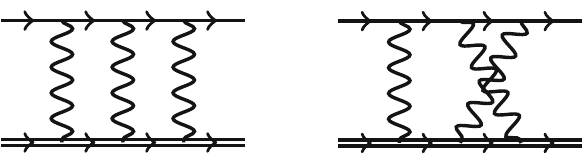
Fig. 7 Representative examples of two-loop diagrams contributing to μ - e scattering at NNLO in QED